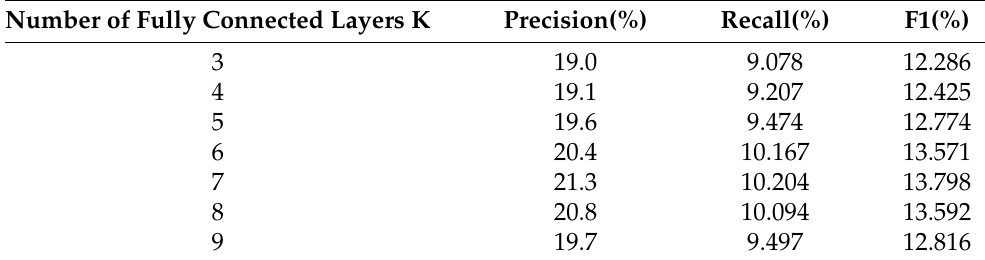
Table 6. Experimental results under different K values.